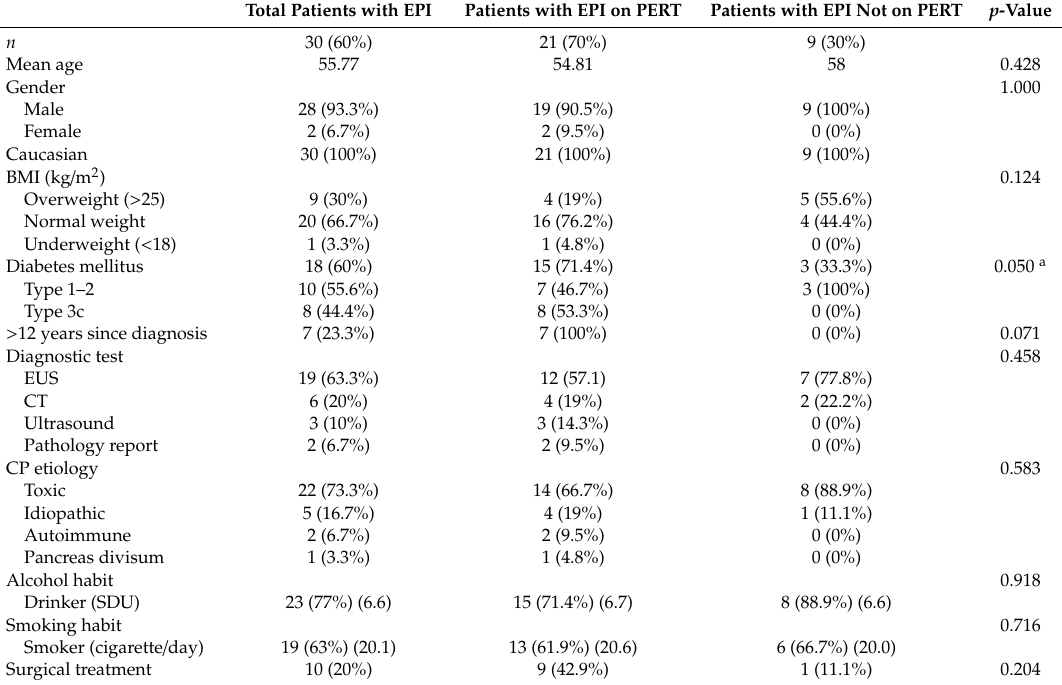
Table 4. Patient characteristics in patients with EPI on PERT and those not on